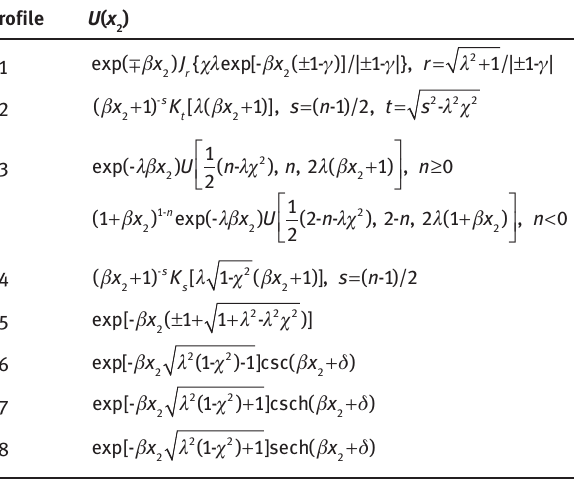
( x ) for the special inhomogeneity profiles. 1 2